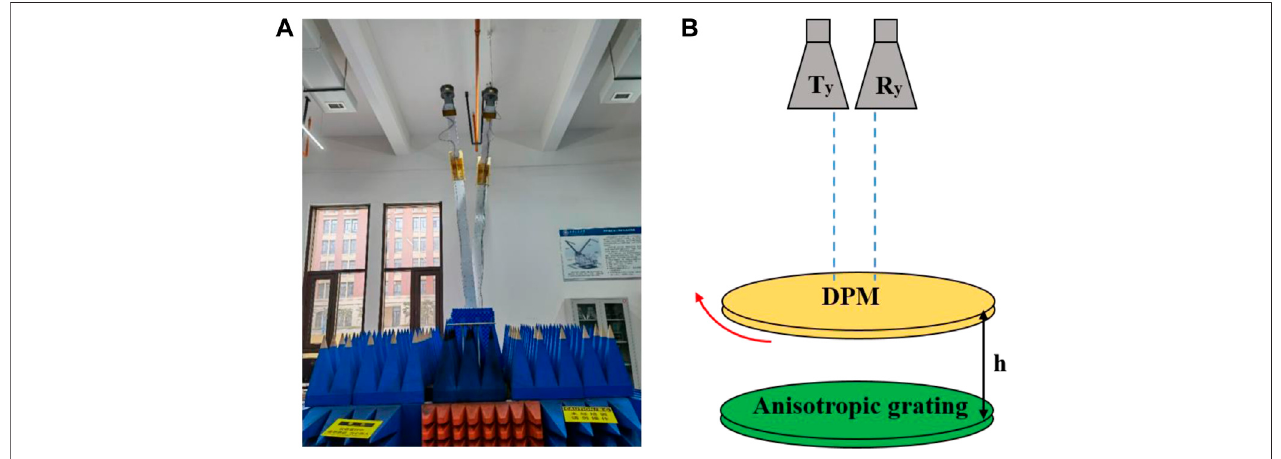
FIGURE 8 | The radar detection experiment. (A) The measurement con fi guration. (B) The DPM is placed on the anisotropic grating, and only the DPM is rotated.